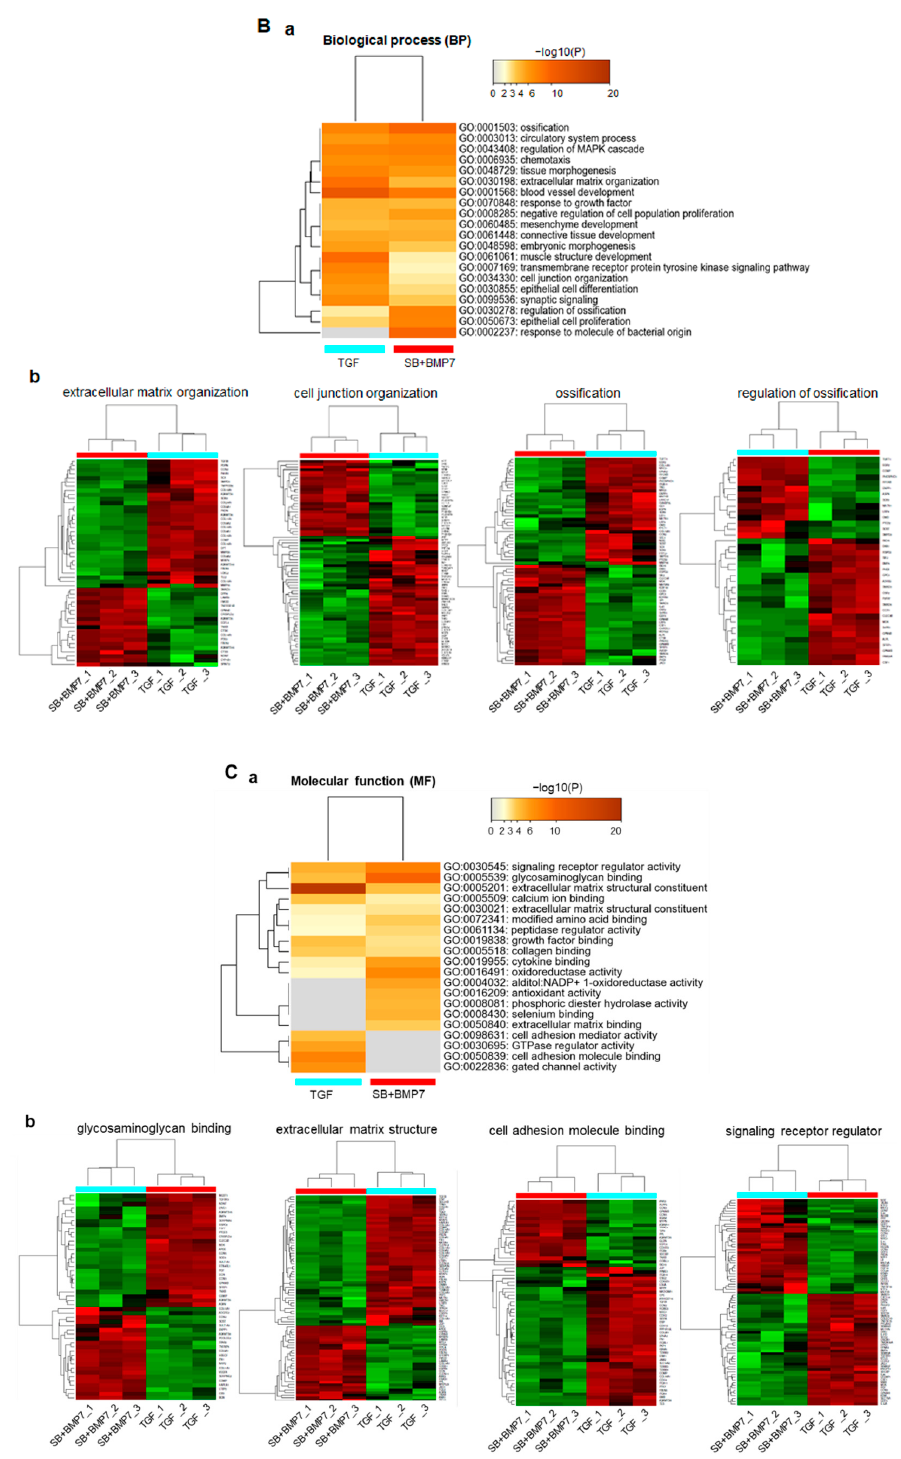
Figure 4. Function prediction analysis for DEGs in TGF- β 1-treated and SB+BMP7-treated hPDLCs using Metascape software. Bar chart of the clustered enrichment ontology categories (GO), in which a discrete color scale represents statistical significance. The function classification of upregulated genes in TGF- β 1- and SB+BMP7-treated hPDLCs is visualized and screened as follows: cellular component (CC) ( A